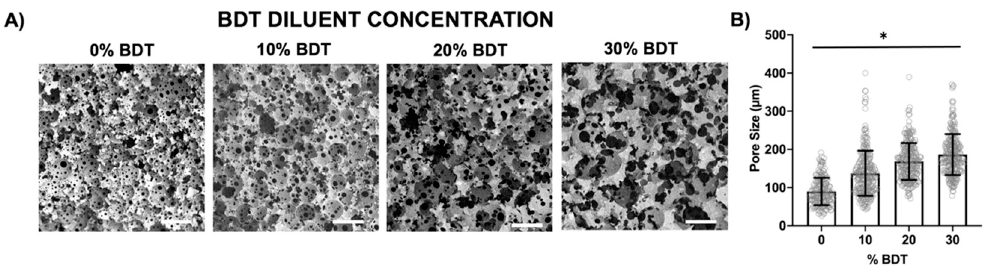
Figure 10. Representative scanning electron micrographs of fracture planes of NGDA polyHIPEs fabricated with 0, 10, 20, and 30 mol% reactive diluent concentration ( A ) and the effect of increasing reactive diluent concentration on polyHIPE pore size ( B ). Scale bar is 100 µm. * denotes statistical significance, p < 0.05.